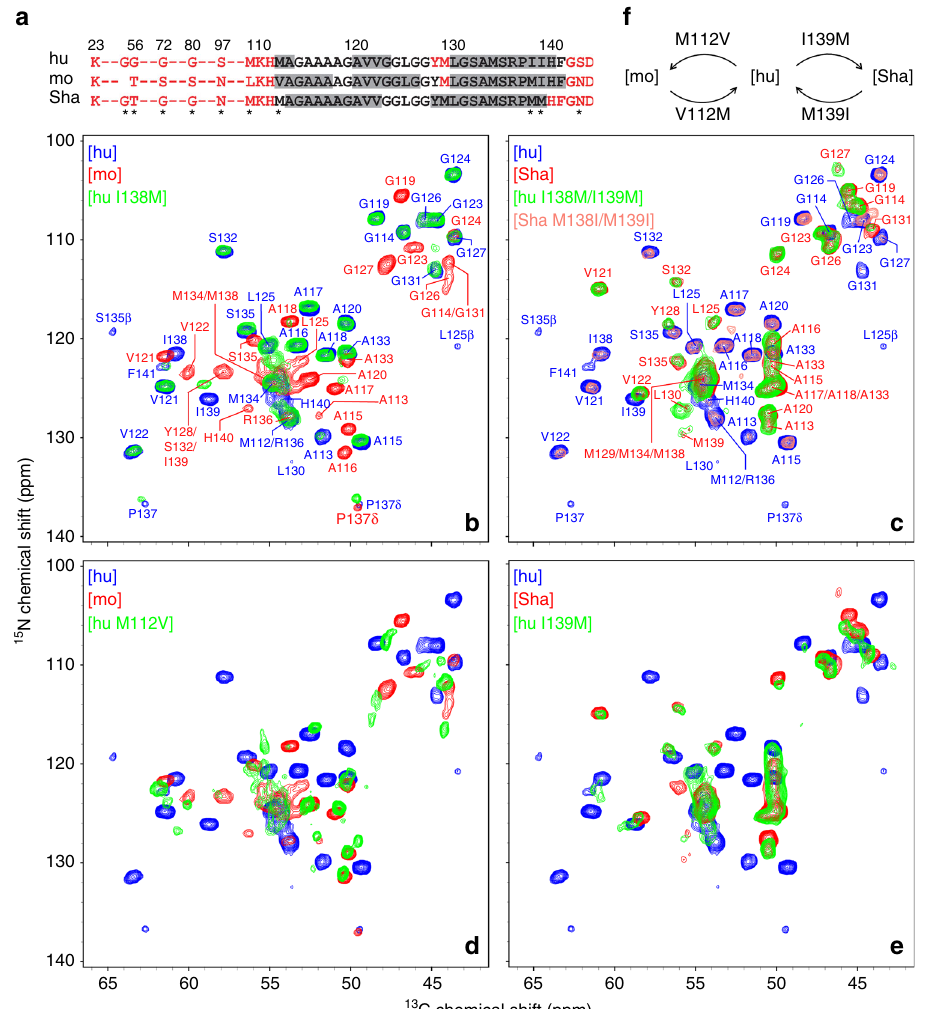
Fig. 1 Two-dimensional 15 N – 13 C α solid-state NMR spectra of PrP23-144 amyloid fi brils. a Amino acid sequences of hu, mo, and ShaPrP23-144. Immobile residues, located within the amyloid β -core and observable in solid-state NMR spectra, are shown in black font , and undetectable, conformationally fl exible residues are shown in red font . Residues having the highest β -strand propensity according to TALOS-N 41 chemical-shift based secondary structure analysis described previously 36 are indicated by gray rectangles . The asterisks indicate all residues that are not conserved between the hu, mo, and ShaPrP23-144 sequences. b – e Two-dimensional 15 N – 13 C α fi ngerprint NMR spectra of PrP23-144 amyloid fi brils recorded at 500 or 800 MHz 1 H frequency, 11.111 kHz MAS rate, and 5 °C. Spectra are shown for a total of eight PrP23-144 amyloids, including the following proteins and their single or double mutants: [hu], [mo], [Sha], [hu M112V], [hu I138M], [hu I139M], [hu I138M/I139M], and [Sha M138I/M139I], as indicated in the insets and by contours of corresponding color. Also shown in corresponding color in b and c are the resonance assignments for [hu], [mo], and [Sha] fi brils 32, 36 . f Summary of the key amino acid substitutions that, based on the solid-state NMR data in this study, are primarily responsible for the PrP23-144 amyloid β -core